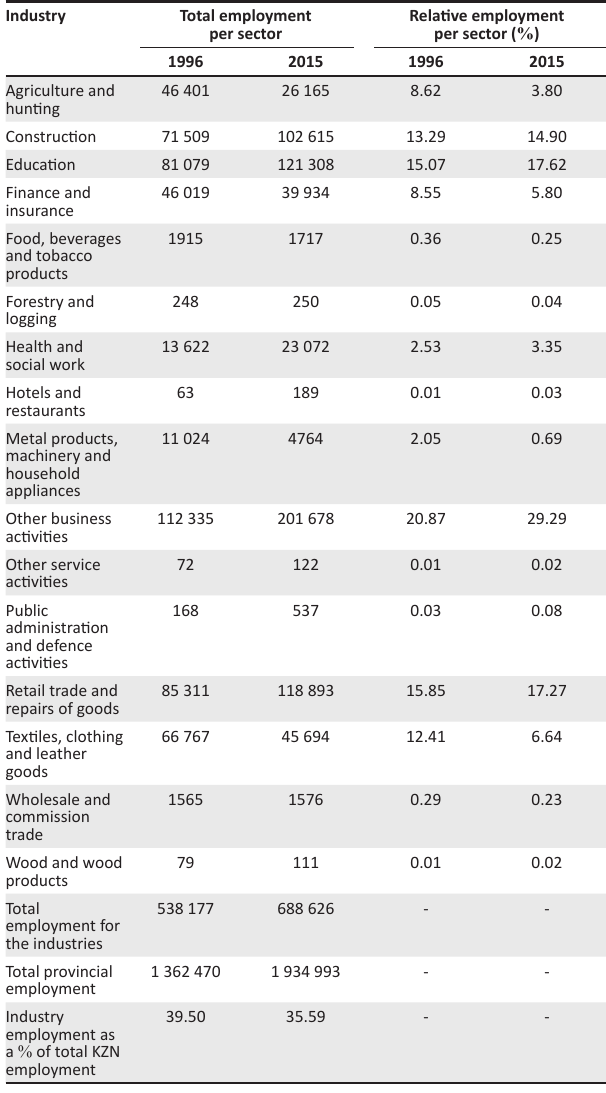
TABLE 1: Description of the data: Panel A – 1996 cities. City